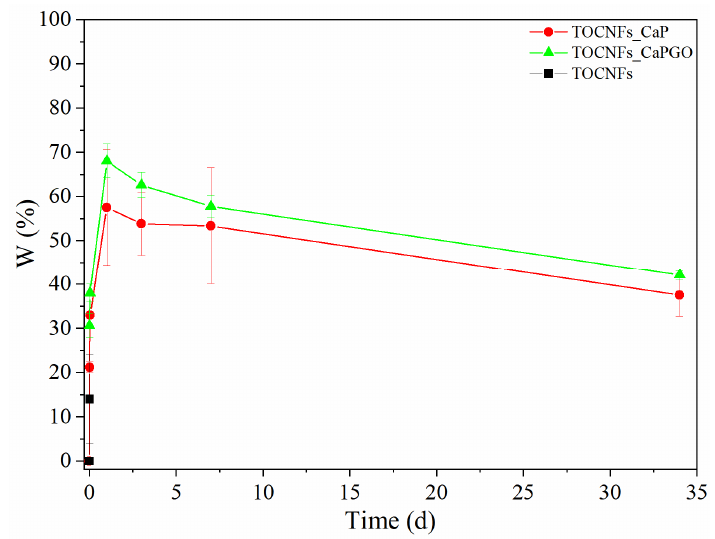
Figure 4. Swelling Test on TOCNFs (black), TOCNFs CaP (red) and TOCNFs CaPGO (green) was performed by immersing the samples in sterile culture medium at 37 °C and carefully weigh the samples at different time steps.